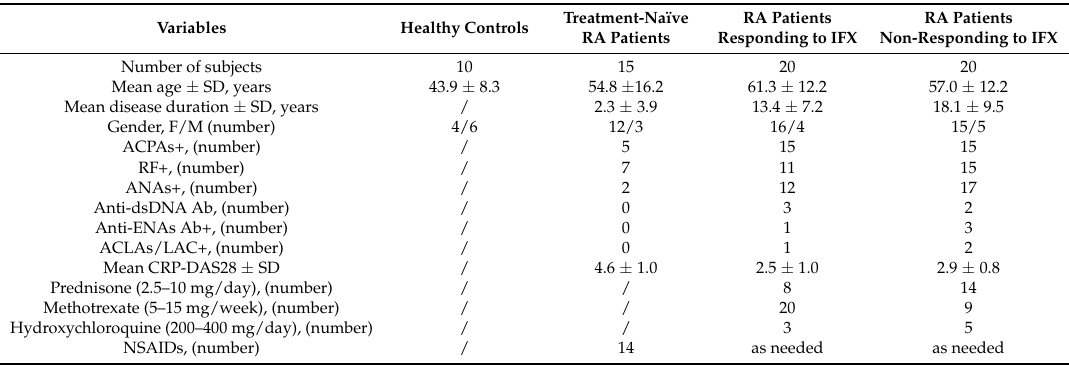
Table 1. Demographic characteristics of the population included in the study. RA: rheumatoid arthritis; IFX: infliximab; SD: standard deviation; F: females; M: males; ACPAs: anti-citrullinated-protein antibodies; RF: rheumatoid factor; ANAs: anti-nuclear antibodies; anti-dsDNA: anti-double stranded DNA antibodies; anti-ENAs: anti-extractable nuclear antigen antibodies; ACLAs: anticardiolipin antibodies; LAC: lupus anticoagulant; CRP-DAS28: C-reactive protein/28-joint disease activity score; NSAIDs: non-steroidal anti-inflammatory